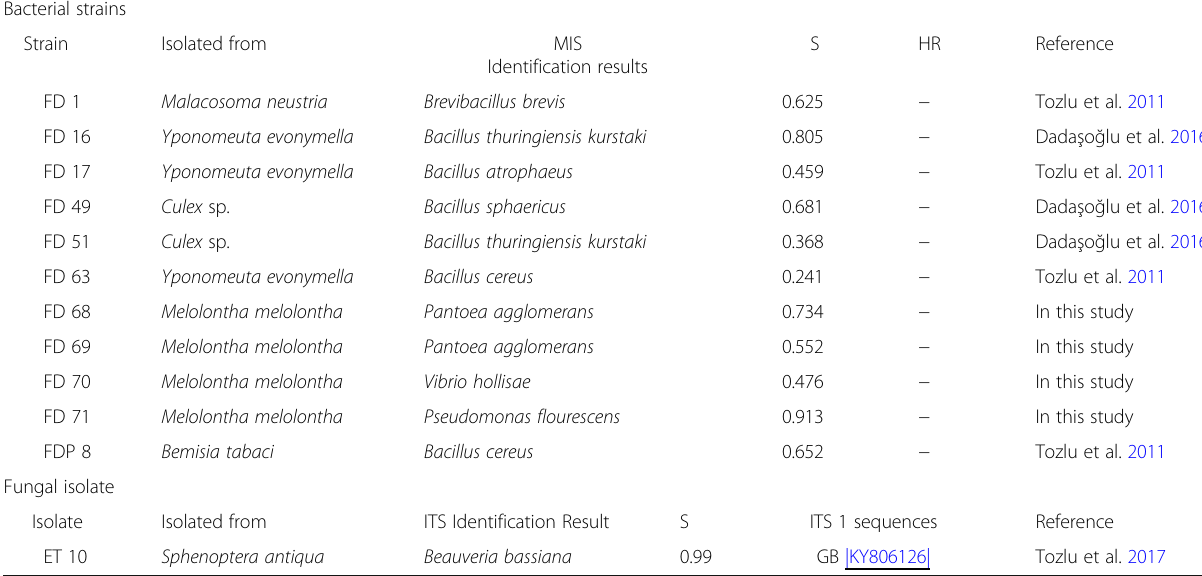
Table 1 Identification and similarity indices of the bacterial strains and fungal isolate used in the study Bacterial strains Strain Isolated